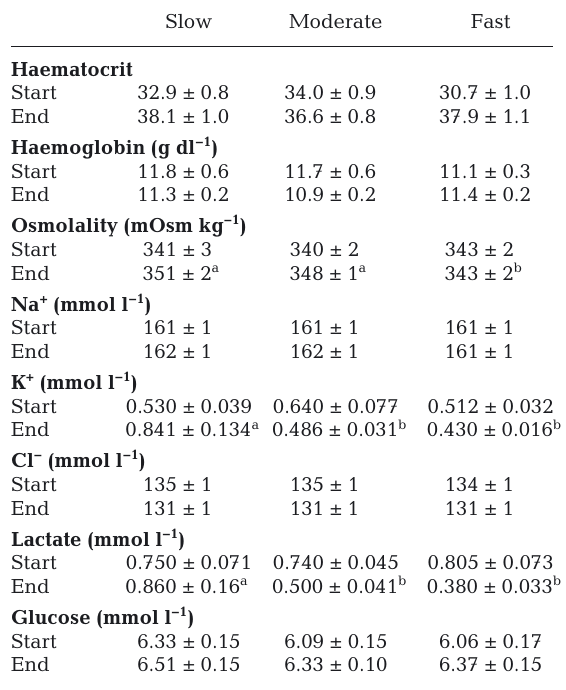
Table 3. Blood chemistry of post-smolt Atlantic salmon Table 2. Muscle composition of post-smolt Atlantic salmon Salmo salar . Data are presented as mean ± SE at the start Salmo salar . Data are presented as mean ± SE at the start and end of the experiment for the different velocity treat- and end of the experiment for the different velocity treat- ments (see Table 1). Significant differences (p < 0.05) ments (see Table 1). Significant dif ferences (p < 0.05) are presented with superscripted letters. DM: dry matter; CrP: creatine phosphate